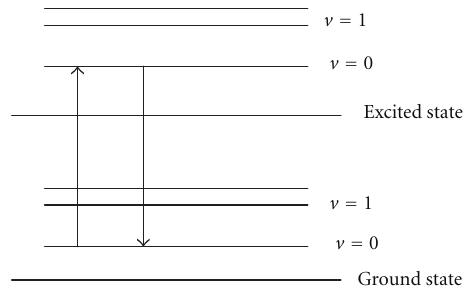
Figure 1: Resonance fluorescence of SiO 2 .